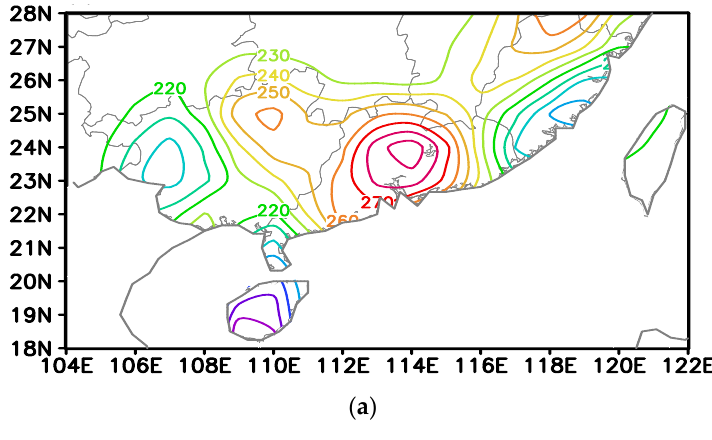
Figure 2. Figure 2. Cont.